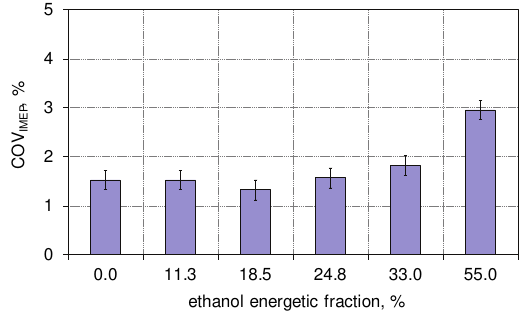
Fig. 6. Coefficient of cycle